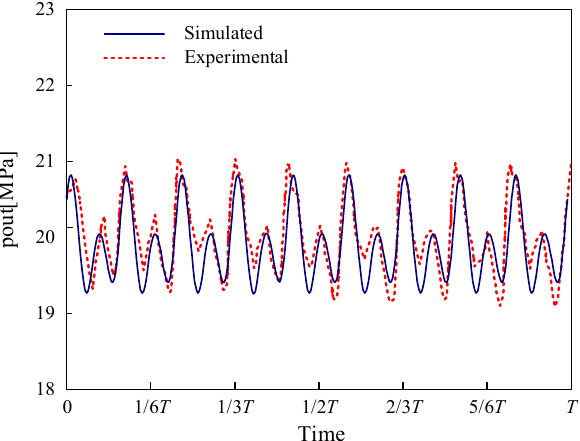
Figure 10. Discharge pressure comparison between the simulated and measured results (under the discharge pressure of 20 MPa and rotational speed of 1000 r/min).